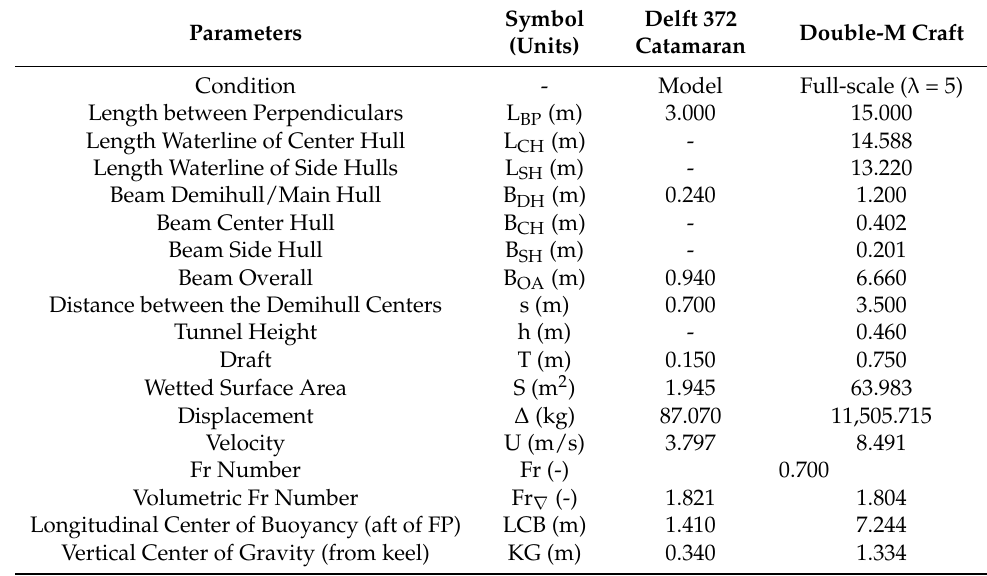
Figure 2. Definitions of the center hull and side hulls arrangement. Table 1. Key features of the benchmark Delft catamaran model 372 and prototype full-scale Double-M craft design.